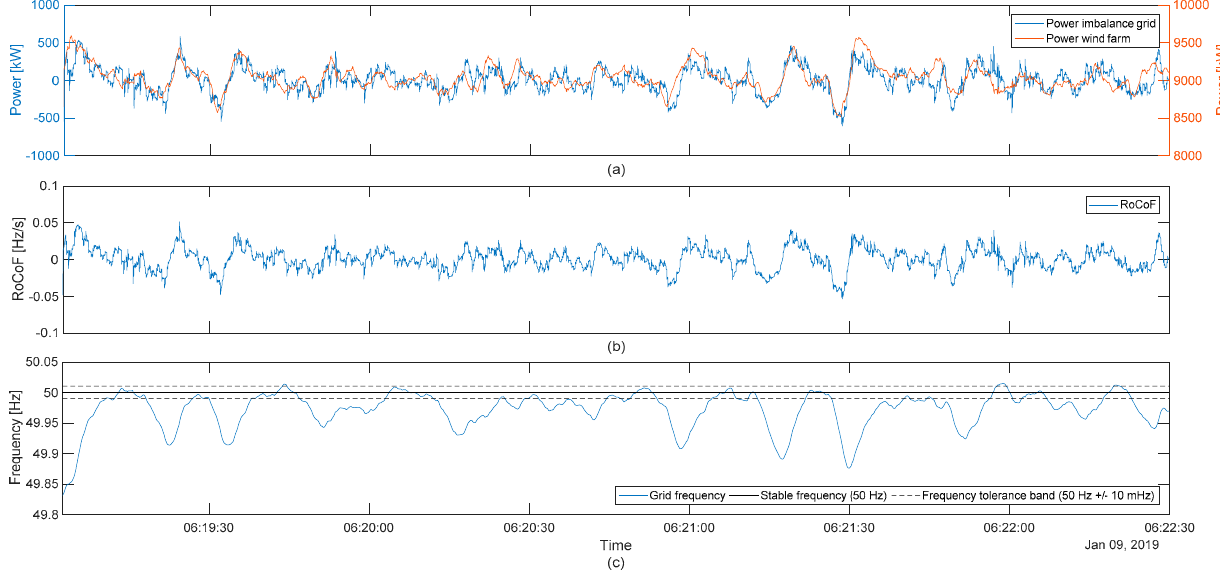
Figure 14. Results of scenario III: ( a ) power imbalance in the islanded grid and power of the simulated wind farm; ( b ) RoCoF; ( c ) grid frequency, stable frequency, and frequency tolerance band.